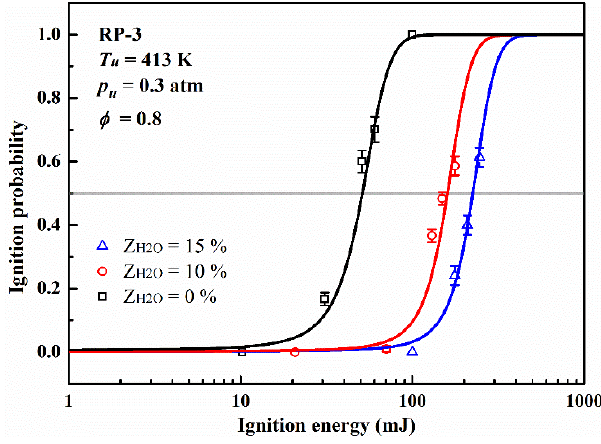
Figure 7. Effects of steam concentration on the ignition probability. ( T u = 413 K, p u = 0.3 atm, ϕ = 0.8, Z O 2 = 21%).